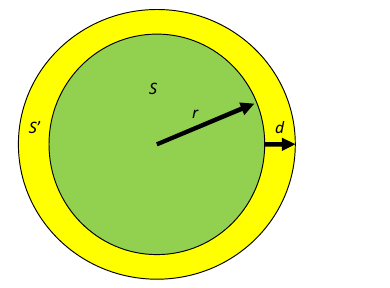
Figure 6. A circular territory with its out-buffer crown